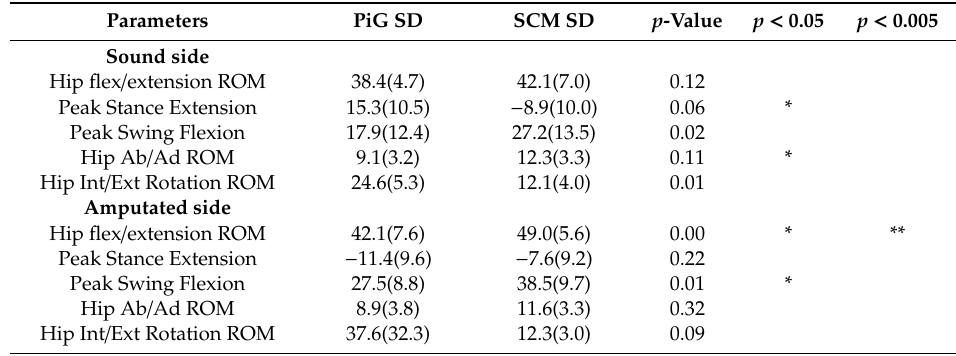
Table 7. Hip joint angle parameters of seven amputee participants on sound and amputated side as mean SD over three gait cycles calculated by the PiG and SCM.